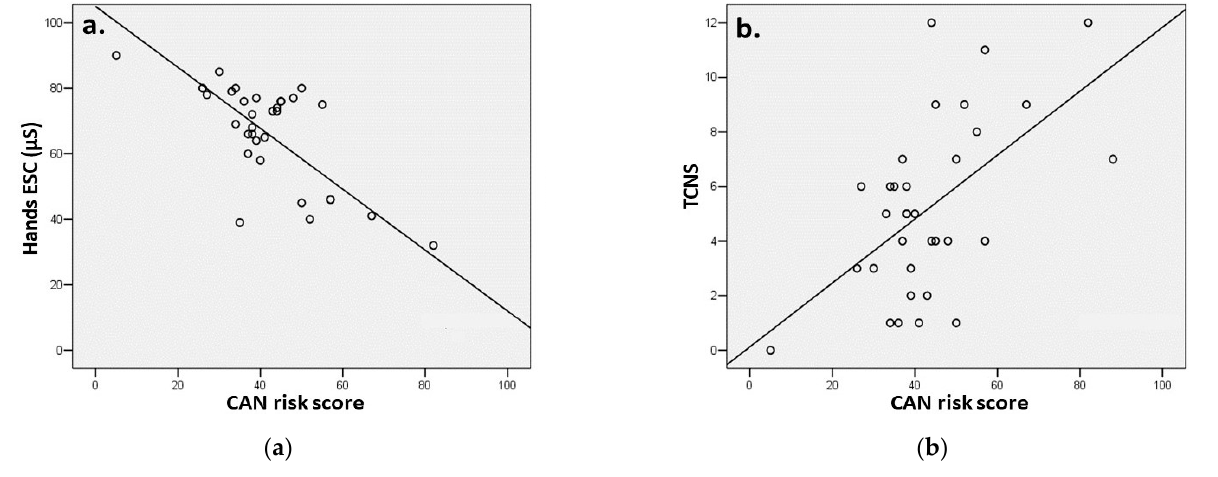
Figure 3. Correlations between the SUDOSCAN CAN risk, hand ESC ( a ) and TCNS ( b ). Abbreviations: CAN—cardiac autonomic neuropathy, ESC—electrochemical sweat conductance, TCNS—Toronto Clinical Neuropathy Score.